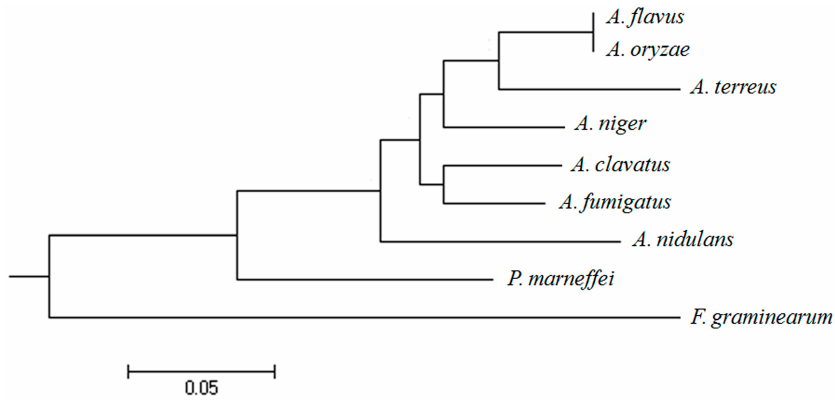
Figure 1. In silico analysis of the afpab1 in A. fumigatus . Protein alignment was performed with ClustalX 2 and the phylogenetic tree was created via MEGA 5.2 to examine afpab1 homologs from different fungi ( Aspergillus fumigatus , AFUA_1G04190; Aspergillus oryzae , AO090003000927; Aspergillus clavatus , ACLA_030250; Aspergillus flavus , AFLA_028910A; Aspergillus niger , An01c0080; Aspergillus terreus , ATEG_03789; Aspergillus nidulans , AN4000.2; Penicillium marneffei ,